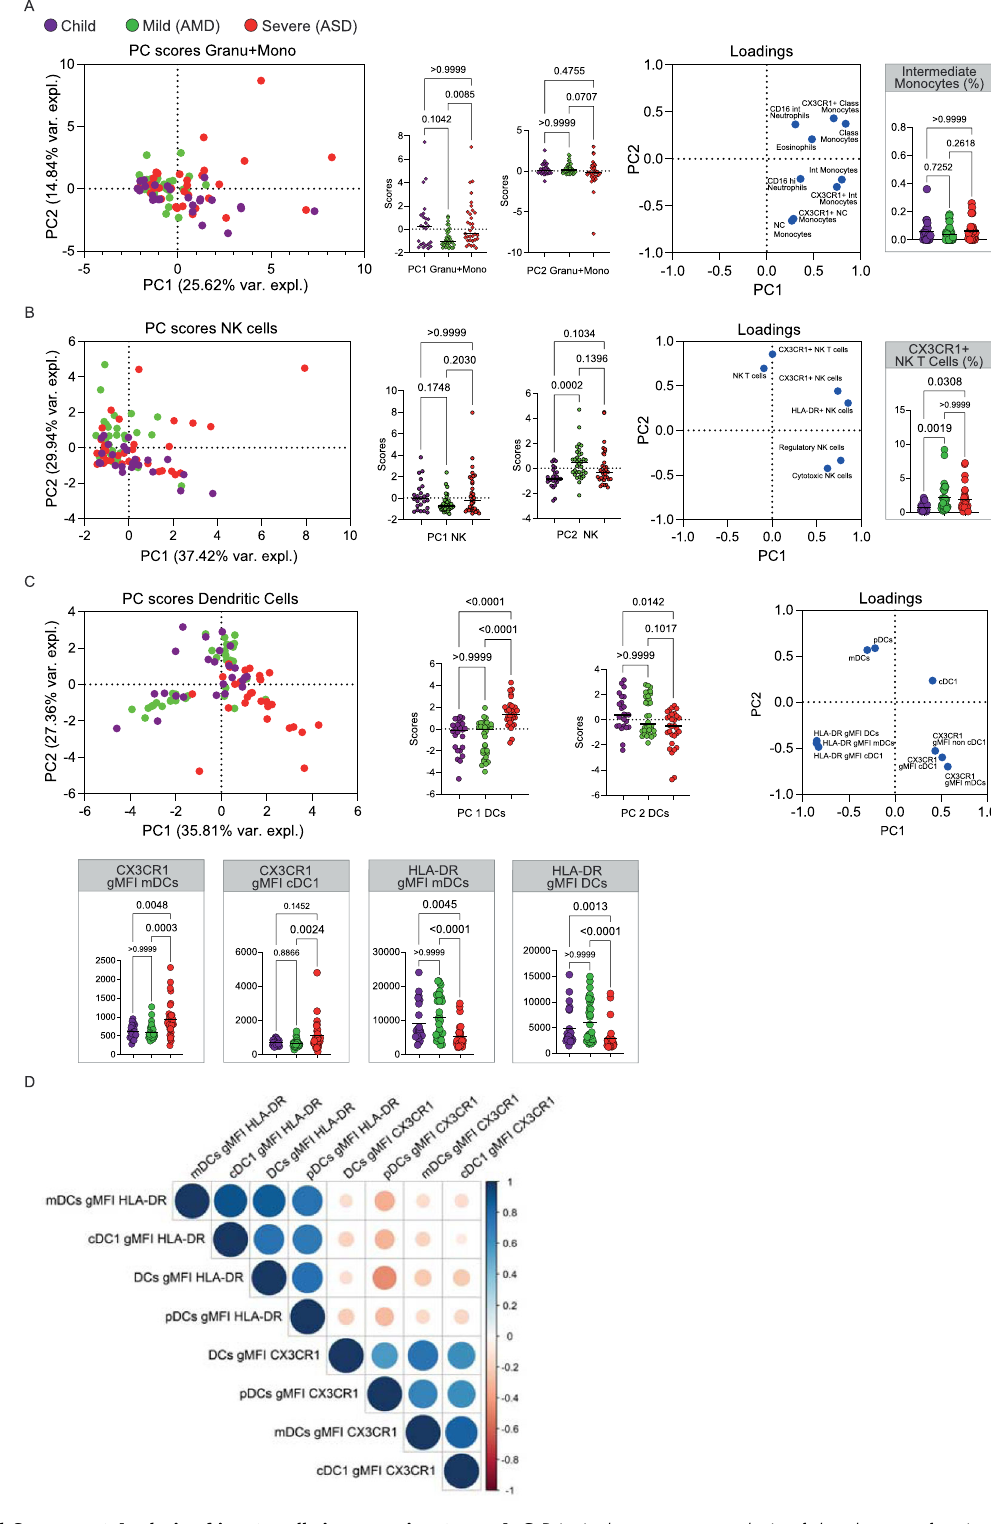
Fig. 3 Principal Component Analysis of innate cells immune signatures. A – G Principal component analysis of the clusters of patients (each dot representing a patient color coded), according to the immune signatures ( A Granu + Mono, Granulocytes and Monocytes; B NK cells; C Dendritic Cells; D Spearman correlation analysis of HLA-DR and CX3CR1 expression in DCS. For each signature, are displayed the PCA plot of PC1xPC2, the differences in scores of individuals for each PC; the loadings of the main variables contributing to each PC and Kruskal – Wallis tests comparisons of the scores of the major contributing variables values for each group of patients. P values are indicated over brackets, the horizontal bar representing the median for scores; and the mean for percentages and gMFI. Source data are provided as a Source Data fi